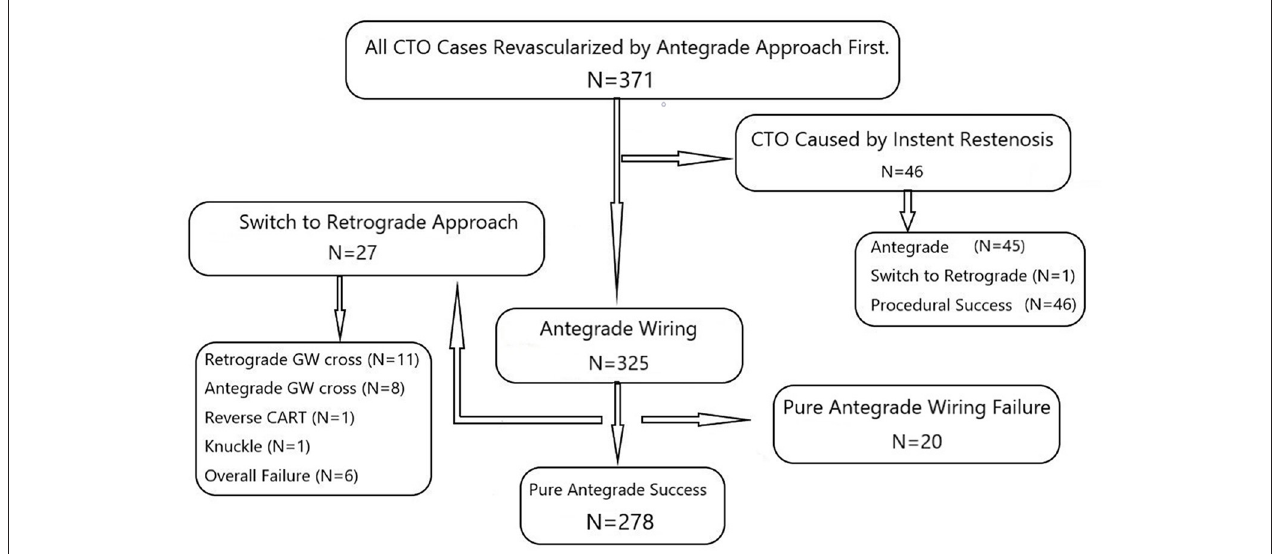
FIGURE 1 | The single-operator cohort with the antegrade-first and wiring-based technique showed 325 procedures for native CTO cases. Twenty-seven cases switching to retrograde techniques and twenty cases with pure antegrade wiring failure were both regarded as the group with antegrade wiring failure ( N = 47). CTO, chronic total occlusion; CART, controlled antegrade and retrograde tracking; GW, guidewire.